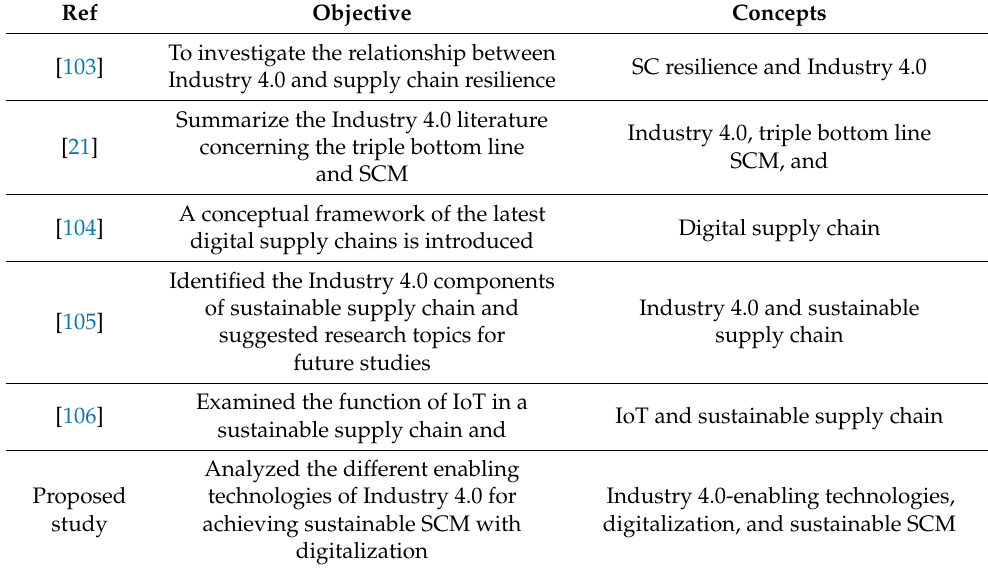
Table 6. Comparison of the current study with previous